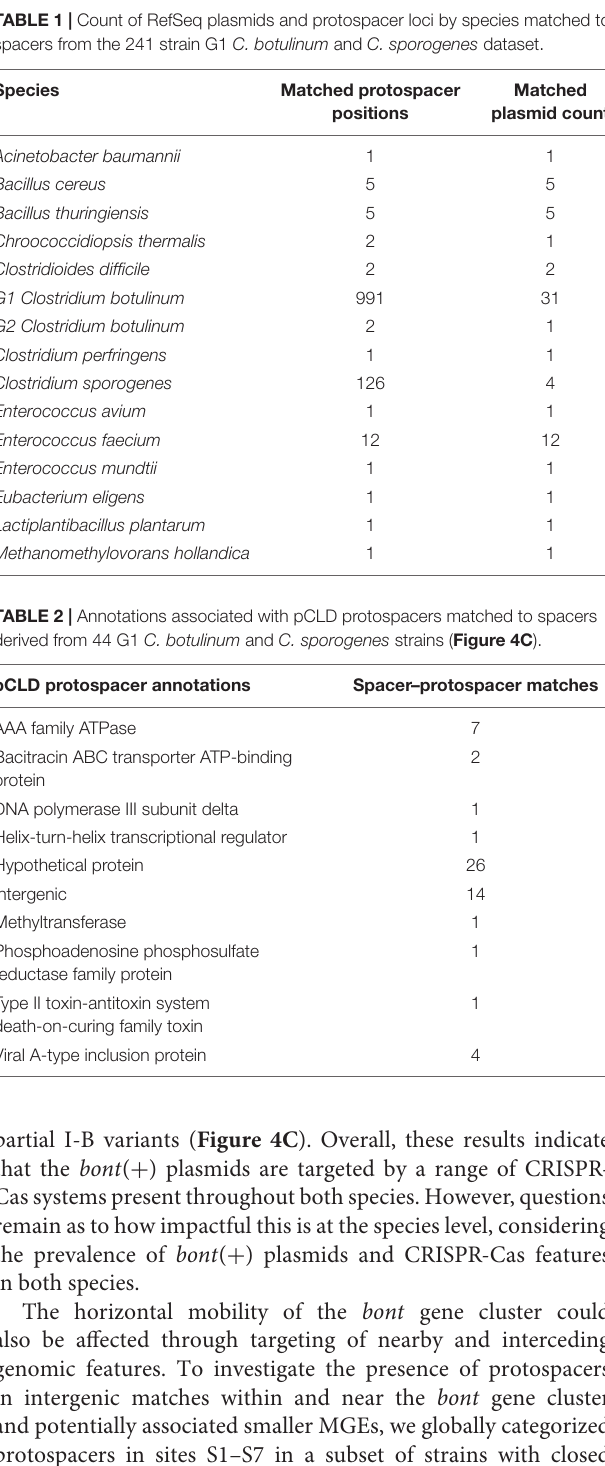
Matched positions plasmid count